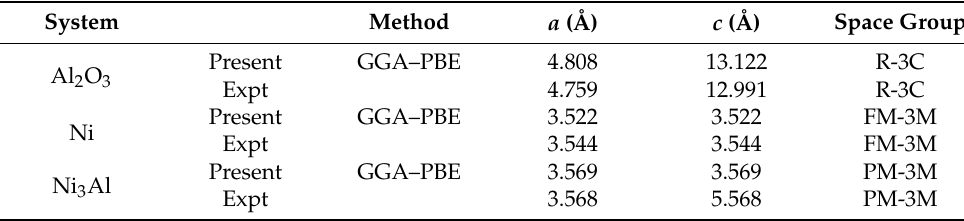
Figure 1. Unit cells of bulk ( a ) Ni, ( b ) Ni 3 Al, and ( c ) Al 2 O 3 . ( d ) Top view of Ni(111)/Al 2 O 3 (001). ( e ) Front view of Ni(111)/Al 2 O 3 (001). ( f ) Top view of Ni 3 Al(111)/Al 2 O 3 (001). ( g ) Front view of Ni 3 Al(111)/Al 2 O 3 (001) interface. The pink, red, and blue ball in figure shows Al, O, Ni atom separately. Table 1. Calculated lattice parameters ( a and c ) of bulk Al 2 O 3 , Ni, and Ni 3 Al.